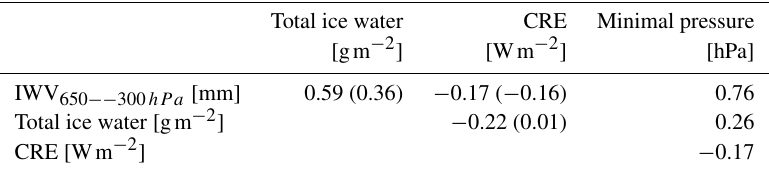
Figure 16. Cross section along − 59.43 ◦ W from 15 ◦ S to 20 ◦ N (dashed white line in Fig. 14) and the position of backward trajectories from the BCO started in the layer 650–300hPa on 14 February (00:00–21:00UTC, every 3h) at (a) 12:00UTC on 7 February, (b) 06:00UTC on 10 February, (c) 15:00UTC on 12 February, and (d) 18:00UTC on 14 February 2020. Trajectory positions not more than ± 1 ◦ W away from the cross section are shown as thin red crosses, which are miniaturized in panel (d) for better readability. Color shading shows relative humid- ity, and contours show potential temperature (gray; 5K intervals), 0 and − 30 ◦ C isotherm (dashed red), upward and downward winds (purple and orange, respectively; ± 0.2, ± 0.4, ± 0.6Pas − 1 ), liquid (continuous blue), snow (dashed white), ice (continuous white; 10mgkg − 1 ), and rain water (dashed blue; 1, 5, 10mgkg − 1 ). The thick red cross marks the location of Barbados. Data: ERA5. Table 6. Pearson correlation coefficient matrix for the daily mean IWV 650–300hPa , total ice water, CRE at the BCO, and the minimal pressure attained during the 10d journey by the trajectories meeting the TMD criterion for the 65 TMDs (and the remaining 587) days of the quasi-climatological period. Data: